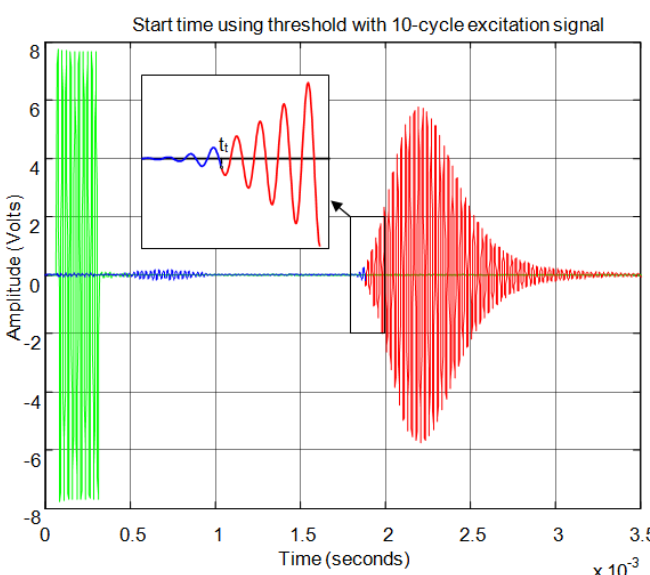
Figure 12. Time of flight detection using